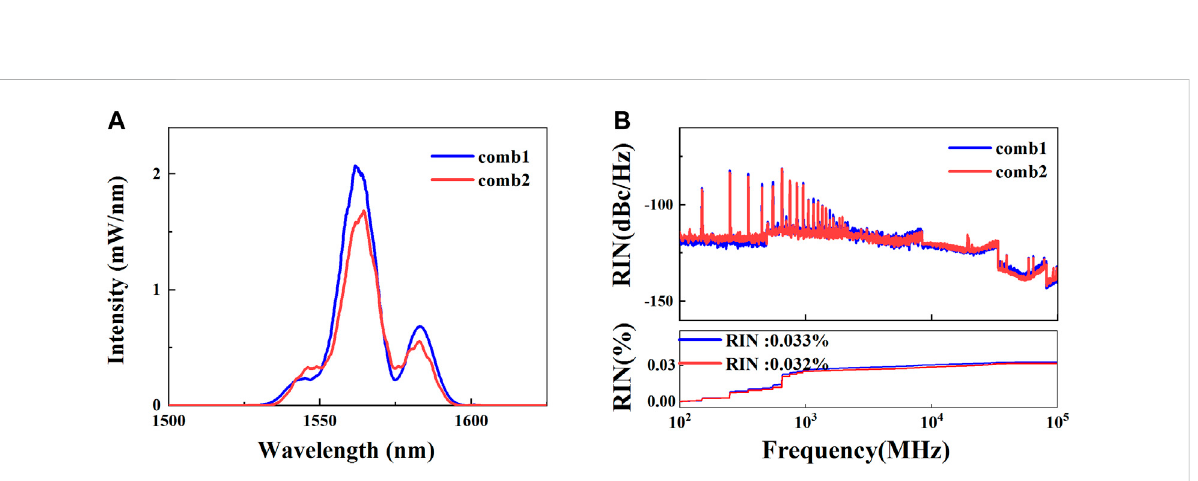
FIGURE 2 (A) Optical spectra and (B) RIN curves of the two frequency